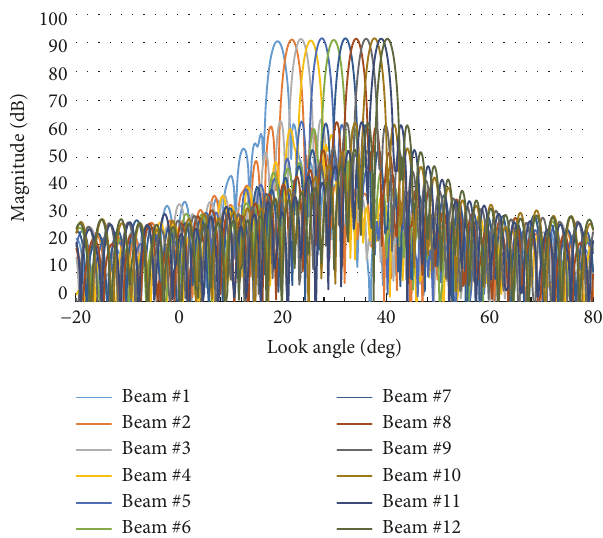
Figure 12: Total synthesized antenna